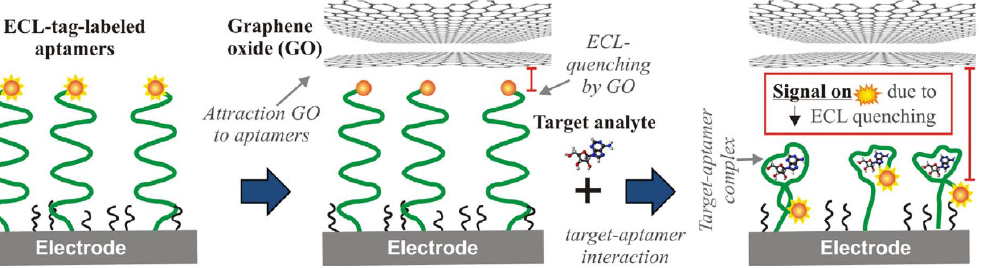
Figure 16. Illustration of GO-based ECL aptasensing. Reprinted with permission from Ref. [215]. Copyright 2017, Elsevier .